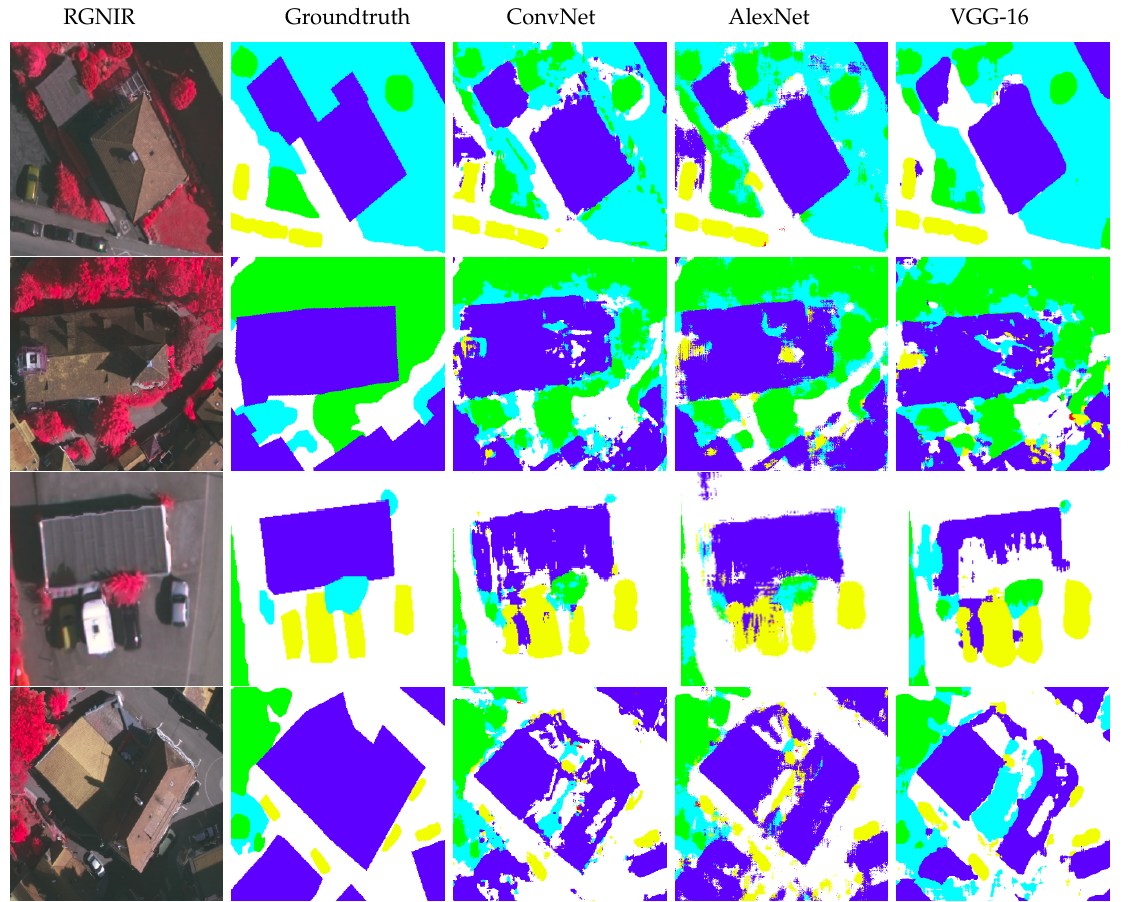
Figure 8. Experimental results from the ConvNet, AlexNet and VGG-16 convolutional networks on indicative regions from the Vaihingen dataset. Along with a false color composite (R-G-NIR), the corresponding ground truth is presented as well (White, Impervious_Surfaces ; Blue, Buildings ; Light Blue, Low_Vegetation ; Green, Trees ; Yellow, Cars ; Red, Clutter